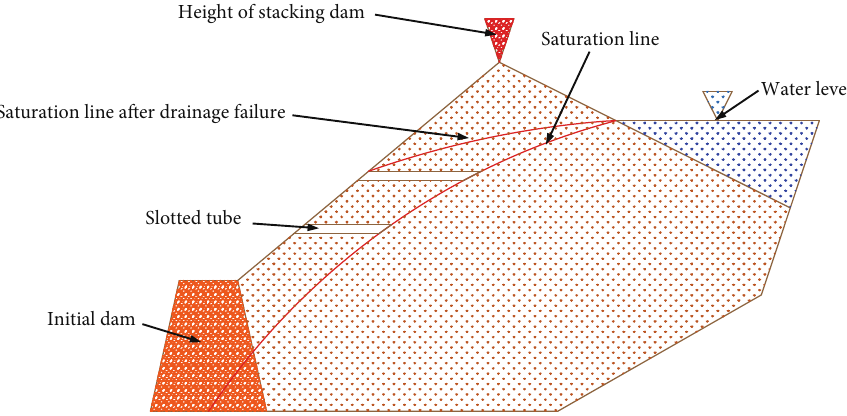
Figure 2: The sketch of saturation